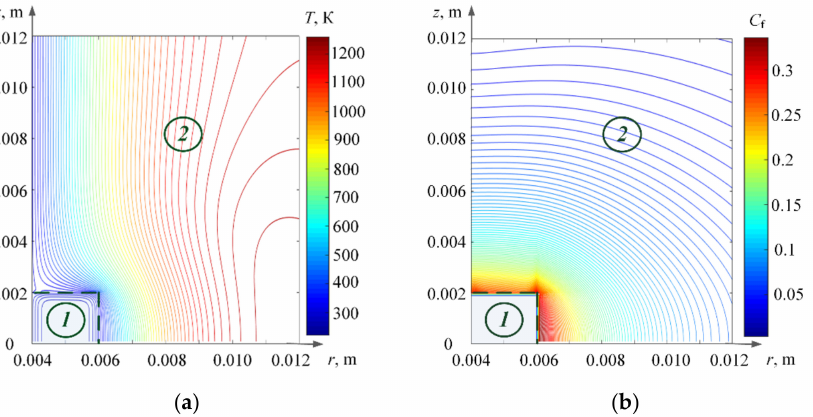
Figure 7. ( a ) Temperature field under convective heating; ( b ) Field of relative concentrations of fuel vapors under convective heating; 1—gel fuel sample, 2—steam–gas mixture. Conditions: T = 1273 K, α = 50 W/(m 2 ·